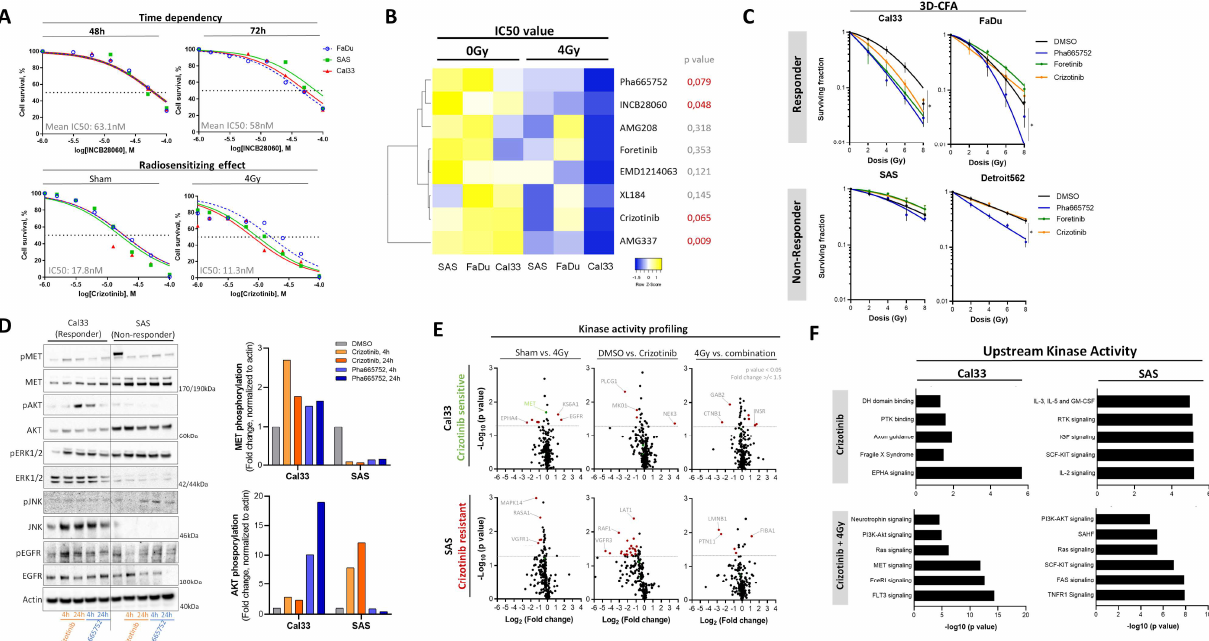
Figure 5. c-MET-specific chemical targeting to induce intracellular sensitization of HNSCC cell lines to ionizing radiation. ( A ) The half maximal inhibitory concentrations (IC50) of eight different c-MET-targeting agents were determined